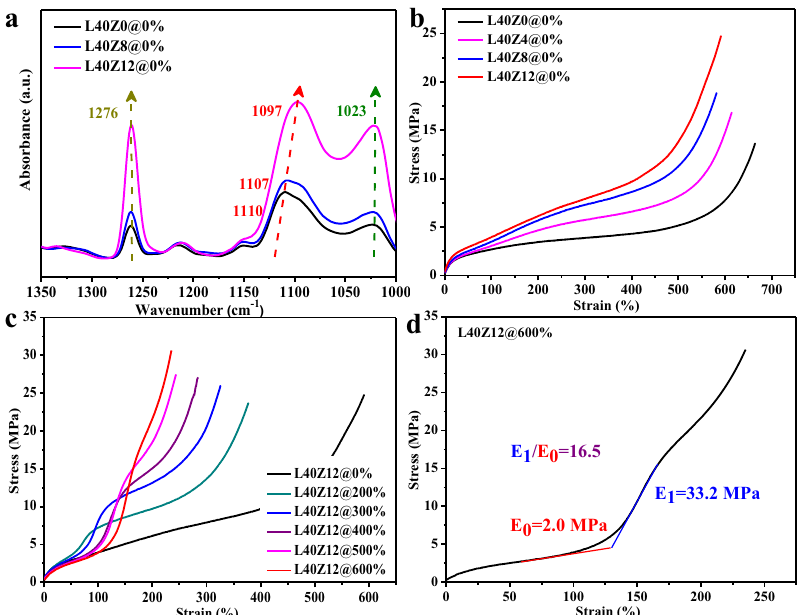
Fig. 2 Mechanical properties of arti fi cal muscle material. a The FTIR spectra of EPDM/lignin composites with different content of ZDMA (a.u. means absorbance unit). b The engineering stress – strain curves of EPDM/lignin composites with different content of ZDMA. c The engineering stress – strain curves of EPDM composites after mechanical training for 250 cycles at the stretching speed of 200 mm/min under different training strain. d The tensile stress – strain curve of L40Z12@600% after mechanical training for 250 cycles at 600% strain. Source Data for Fig. 2a – d are available as an associated article fi